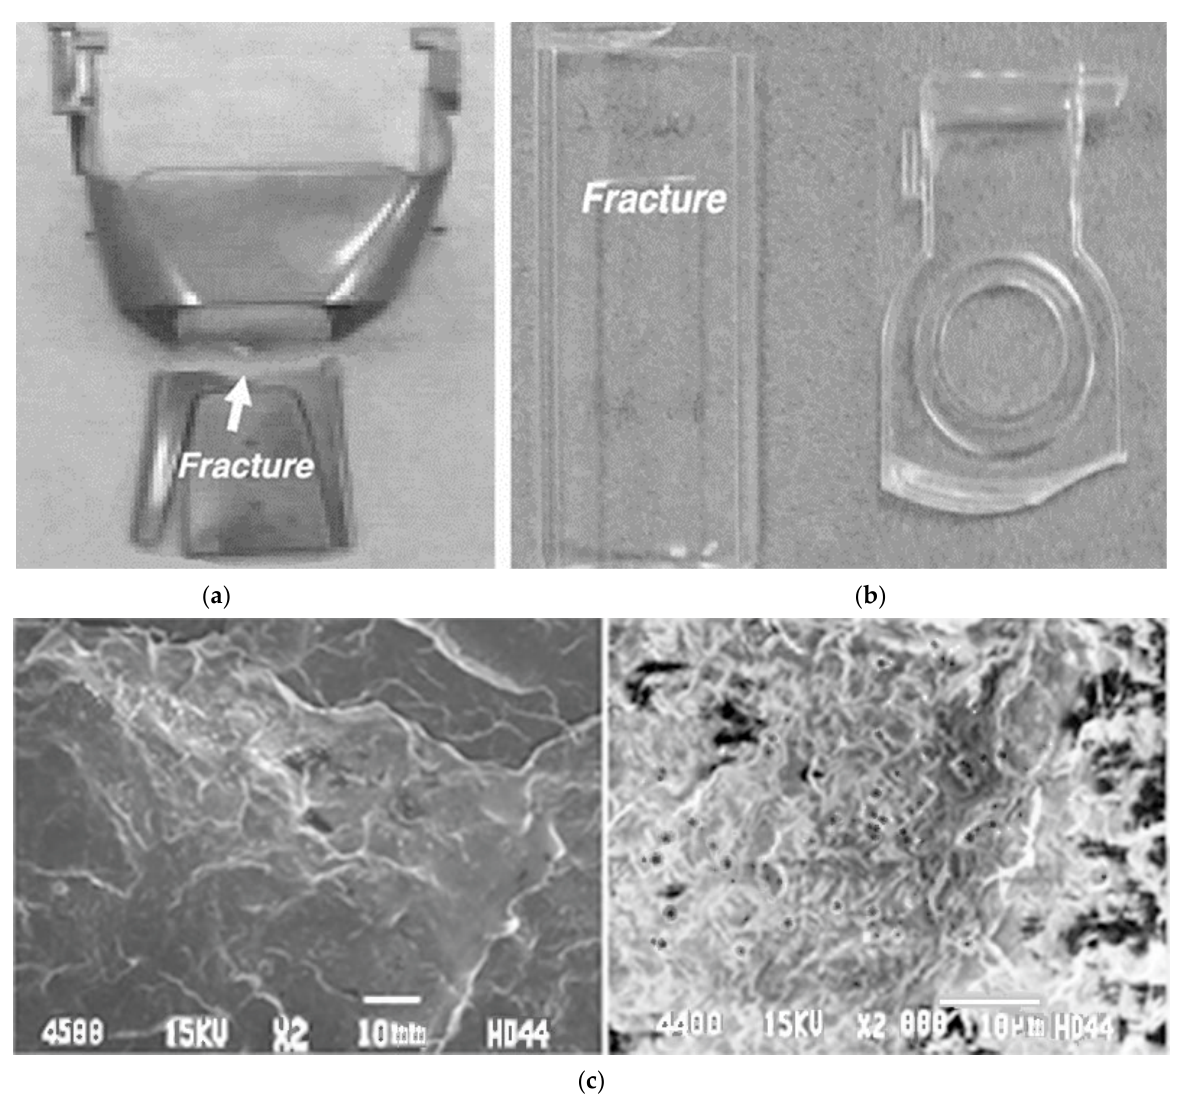
Figure 11. Failed water dispensers from the market and in the first ALT. ( a ) Failed product from the market, ( b ) fractured dispenser within the first ALT, and ( c ) SEM micrographs of fractured surfaces.